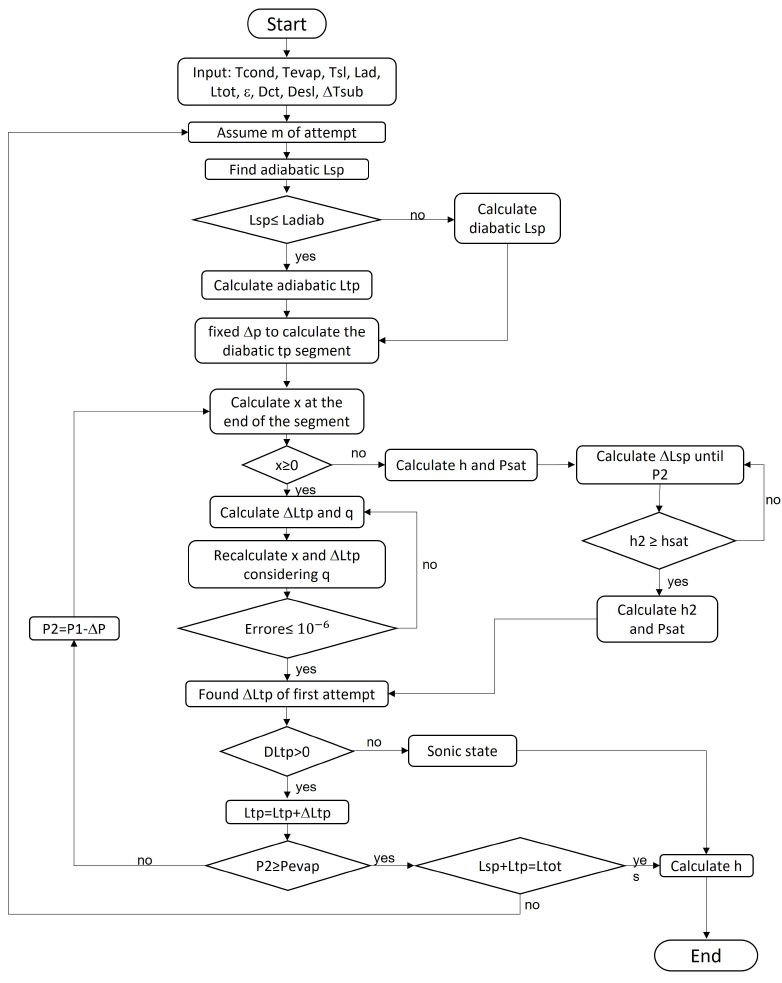
Figure 2. Flow chart of the simulation program of the capillary tube.